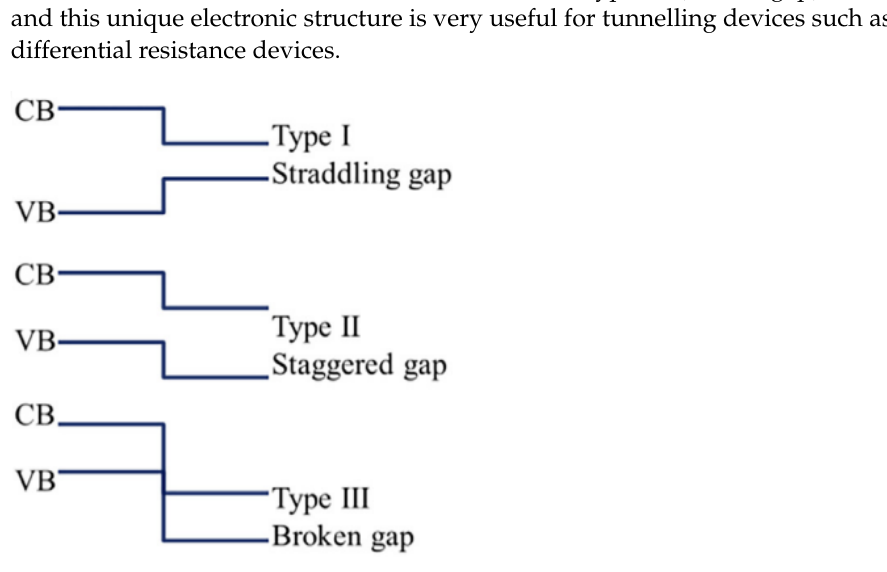
Figure 14. Schematic energy band diagrams of the three types of semiconductor heterojunctions: type-I (straddling gap); type-II (staggered gap); and type-III (broken gap) heterojunctions. (Reproduced with permission from ref. [202]. Copyright 2019 Elsevier Publications.).